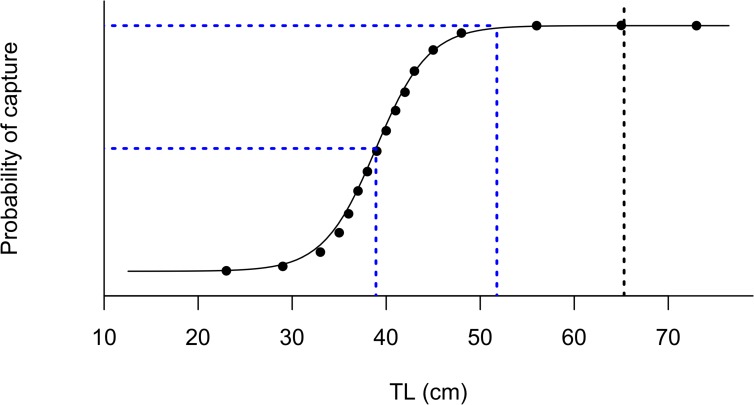
Selectivity of bacalao from length data collected in 2012.The black line represents the logistic selectivity model, the blue lines represent size at 50% and 100% recruitment to the fishery, and the black dotted line represents size at which 50% of the population reaches sexual maturity (Lm).